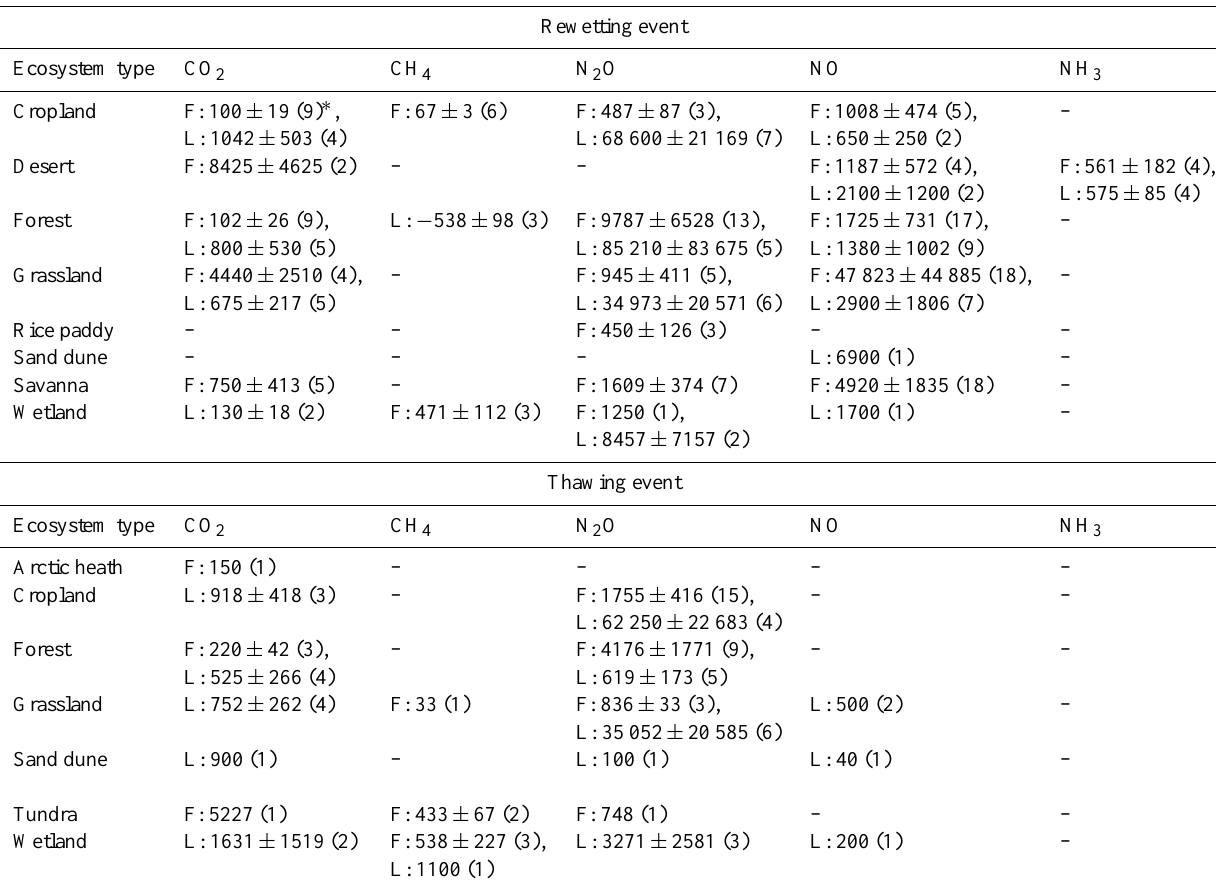
Table 2. Change rate (%) of soil gas flux following rewetting and thawing events observed in various ecosystems (results from compiled dataset analysis). F=field observation; L=laboratory experiment. Rewetting